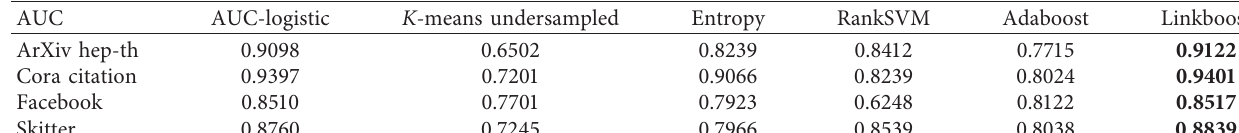
Table 2: Comparison of link prediction results.